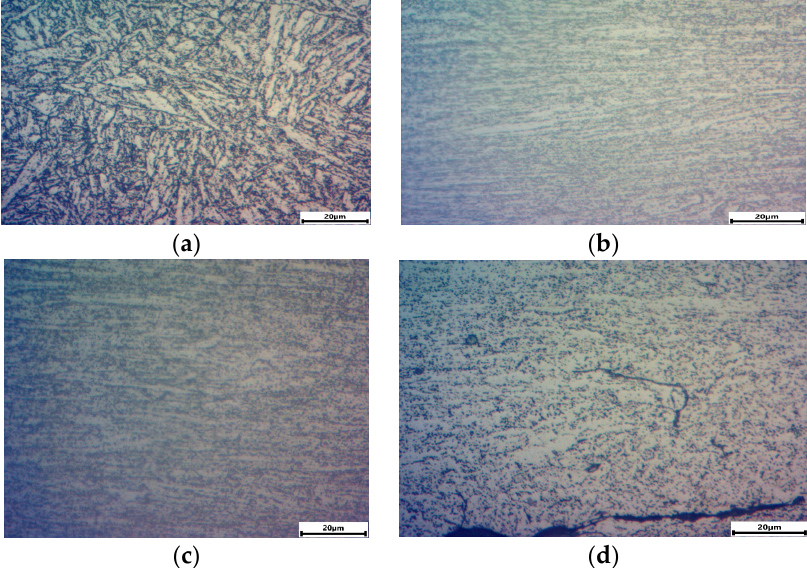
Figure 13. P91 steel microstructure: ( a ) the initial material, ( b ) after uniaxial tension test ( 𝑇 = 600 °C), ( c ) after creep test ( 𝑇 = 600°C, 𝜎 = 258 MPa), ( d ) after fatigue test ( 𝑇 = 600 °C, 𝜎 (cid:3028) = 258 MPa). ( c ) after creep test ( T = 600 ◦ C, σ = 258 MPa), ( d ) after fatigue test ( T = 600 ◦ C, σ